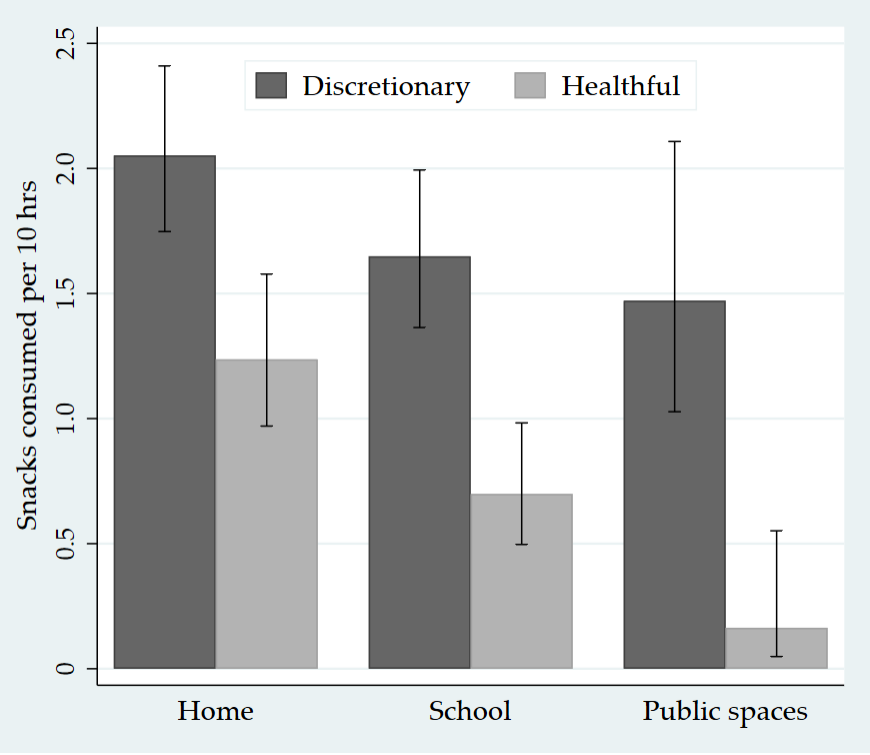
Figure 2. Children’s consumption of discretionary and healthful snacks per 10 h by eating location.